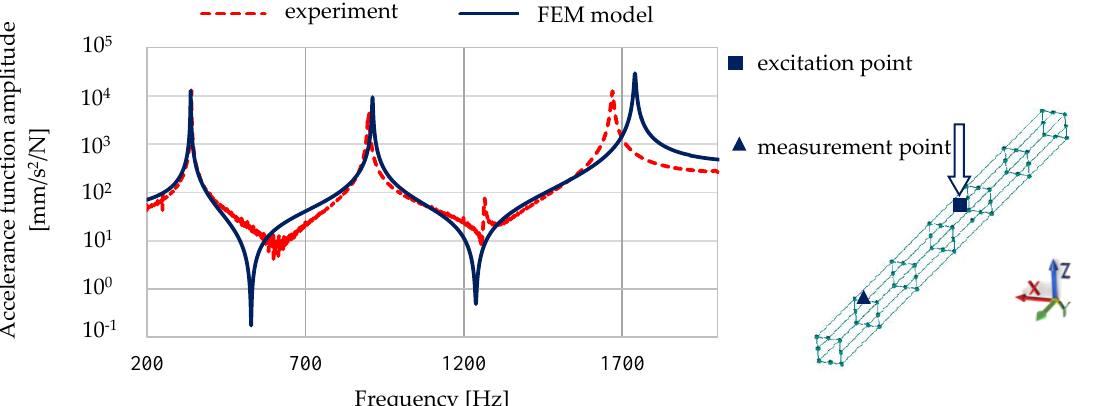
Figure 9. Experimental verification of the accelerance function for the model of a steel–polymer concrete beam with identified parameters.